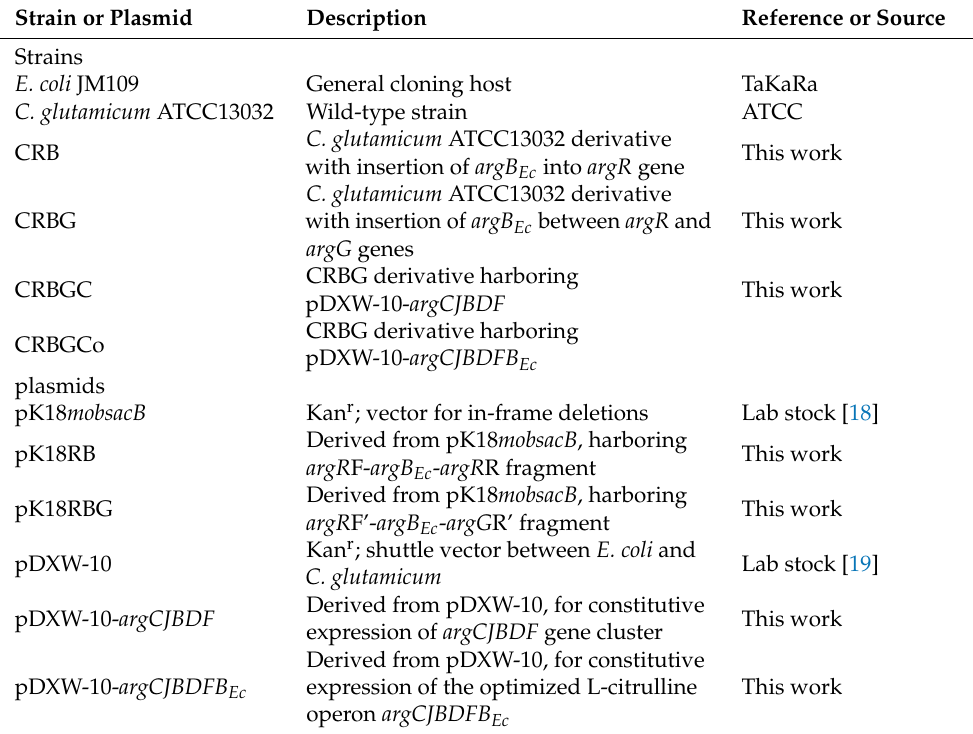
Table 1. Strains and plasmids used in this